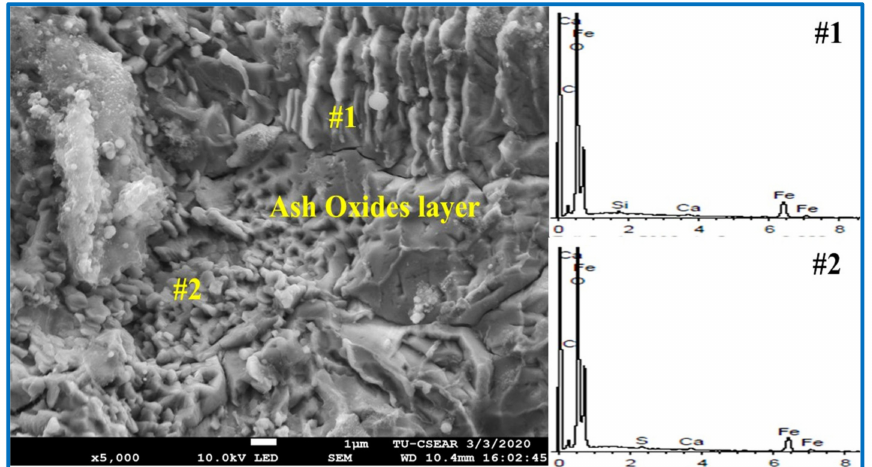
Figure 11. SEM micrograph ( × 5000) on the surface of the metallic Fe droplets obtained after high- temperature interaction of the CCP for 30 min in the case of